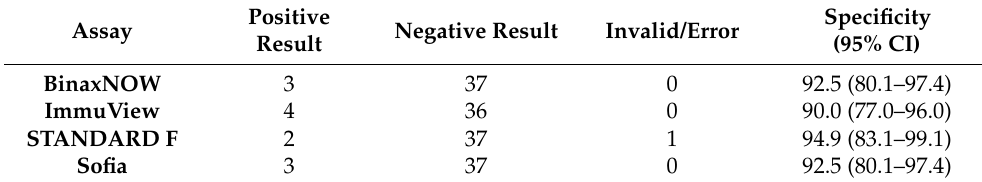
Table 3. Specificities of four Legionella urine antigen assays.